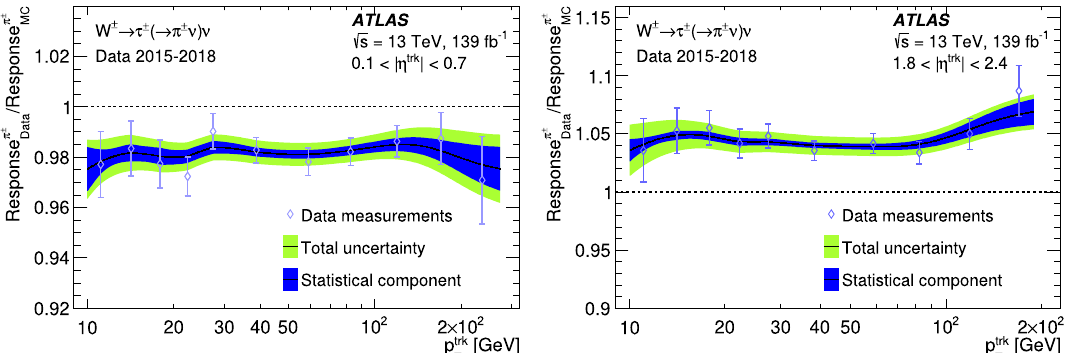
Fig. 5 The various systematic uncertainties which affect the measurement of the calorimeter energy scale for charged pions as a function of | η trk | < 50 GeV, 50 < p trk < 70 GeV and 70 < p trk < 100 GeV for three p trk ranges: 30 < p trk T T T T